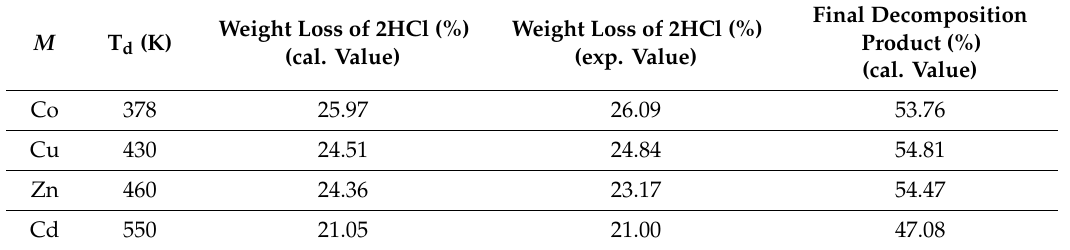
Table 2. The decomposition temperature, T d , mass loss of 2HCl, and final decomposition product M Cl 2 for four crystals.